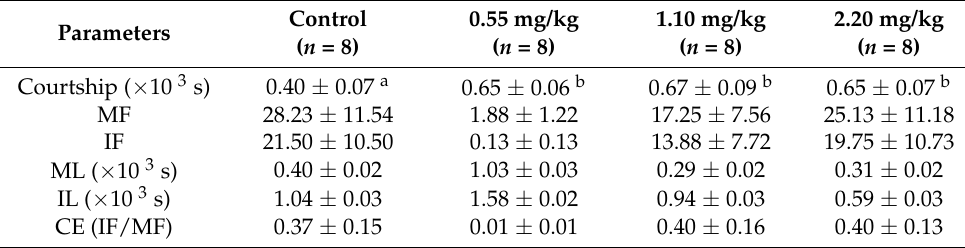
Figure 3. Percent inhibition of LPO ( A ) and AGEs ( B ) of M. oleifera leaf tea. Data are Figure 3 . Percent inhibition of LPO ( A ) and AGEs ( B ) of M . oleifera leaf tea . Data are mean values ± mean values ± standard error (error bars). standard error ( error bars ). Table 2. Sexual behavior parameters of male rats treated with M. oleifera leaf tea and the control group.